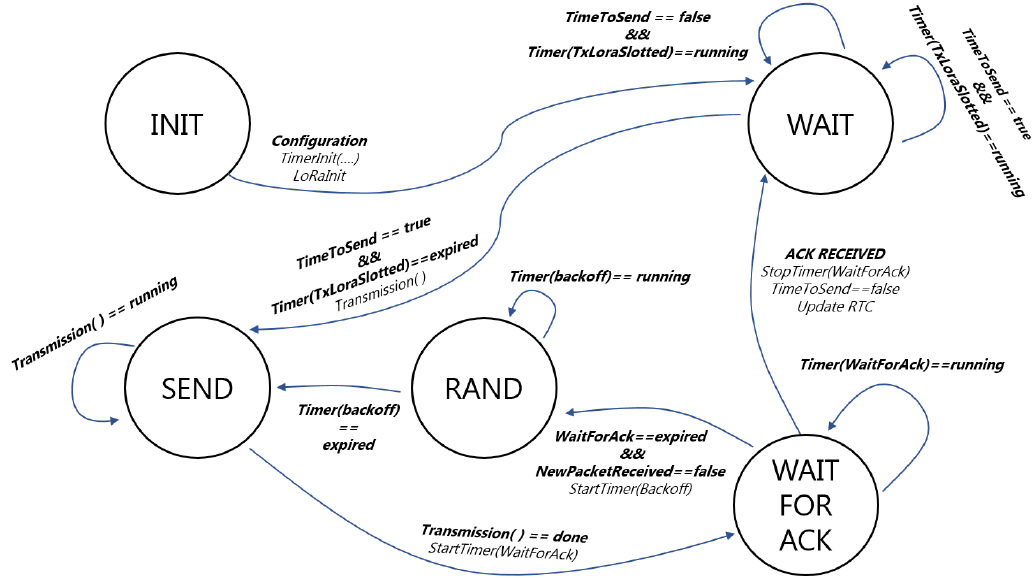
Figure 9. S-LoRaWAN block diagram.